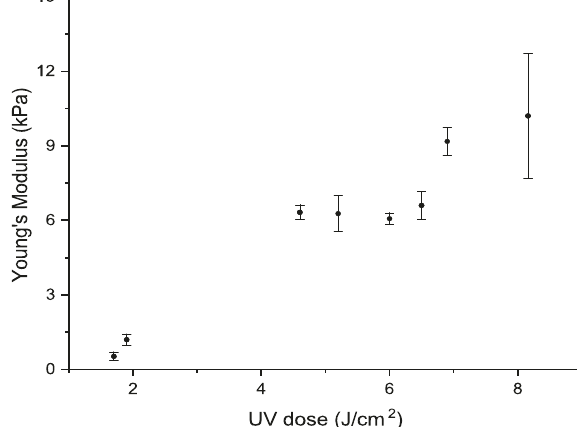
Fig. 4 Young ’ s Modulus of the bulk hydrogel cross-linked at different UV doses. Error bars represent standard deviation from n = 3